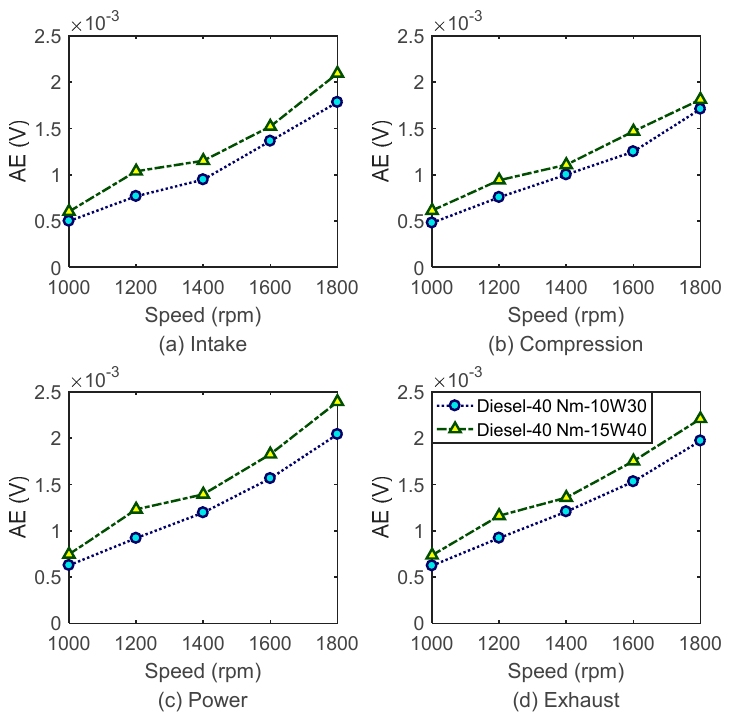
Figure 11. FAS–AE indicators of two base line under high load: ( a ) Intake; ( b ) Compression; ( c ) Power; ( d ) Exhaust.